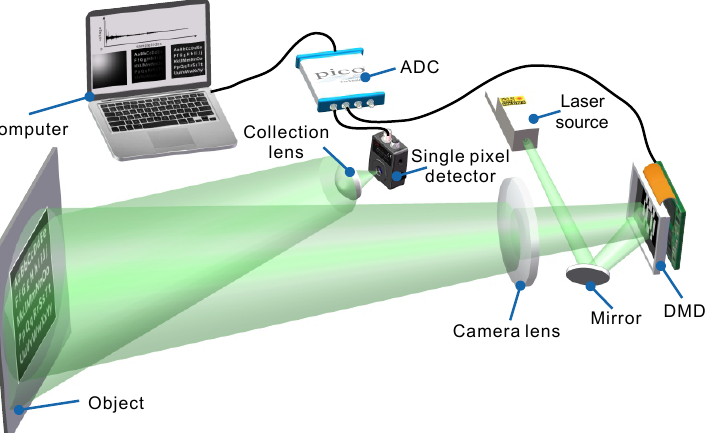
Figure 3. Experiment system setup. The object was illuminated by a laser beam which was